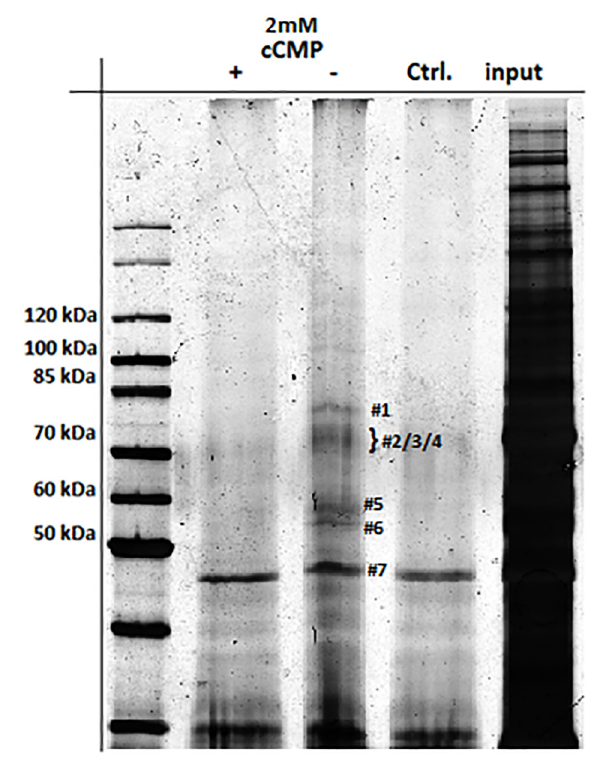
Fig 3. Identification of cCMP-binding proteins. Analysis of lung tissue lysates of wild type mice by immunoprecipitation (using 4-AH-cCMP agarose or EtOH-NH agarose as a control), gel electrophoresis and silver staining. Proteins were detected by mass spectrometric analysis (see S1 Table). cGKI is designated with 1, serum albumin with 2 and 4, HSP7C and 5 ’ -nucleotidase with 3, cAKII α /I α reg with 5/6, actin and 60S ribosomal protein L4 with